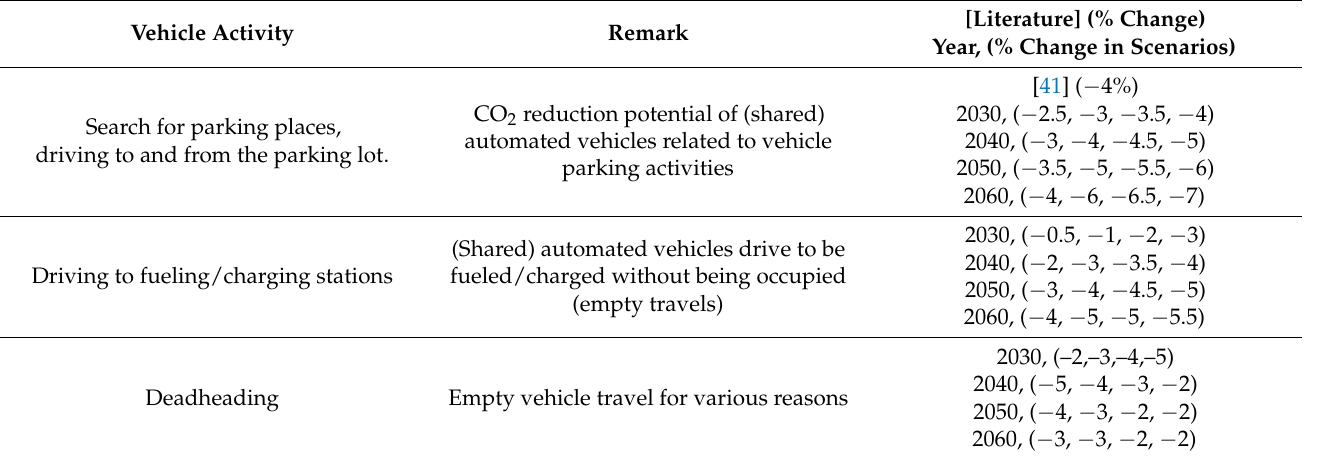
Table 4. Impacts of vehicle parking, fueling, and charging on road transportation